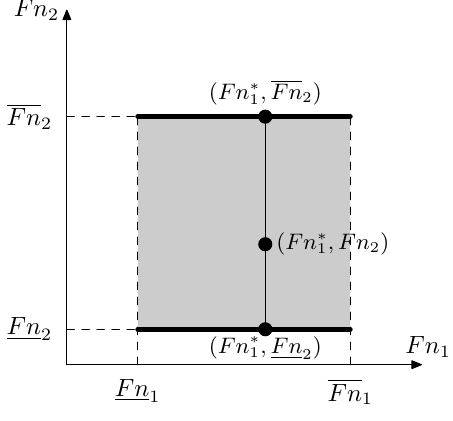
Fig. 1. Solving systems with two fuzzy coef- ficients where the second fuzzy number is a diagonal element in ˜ A